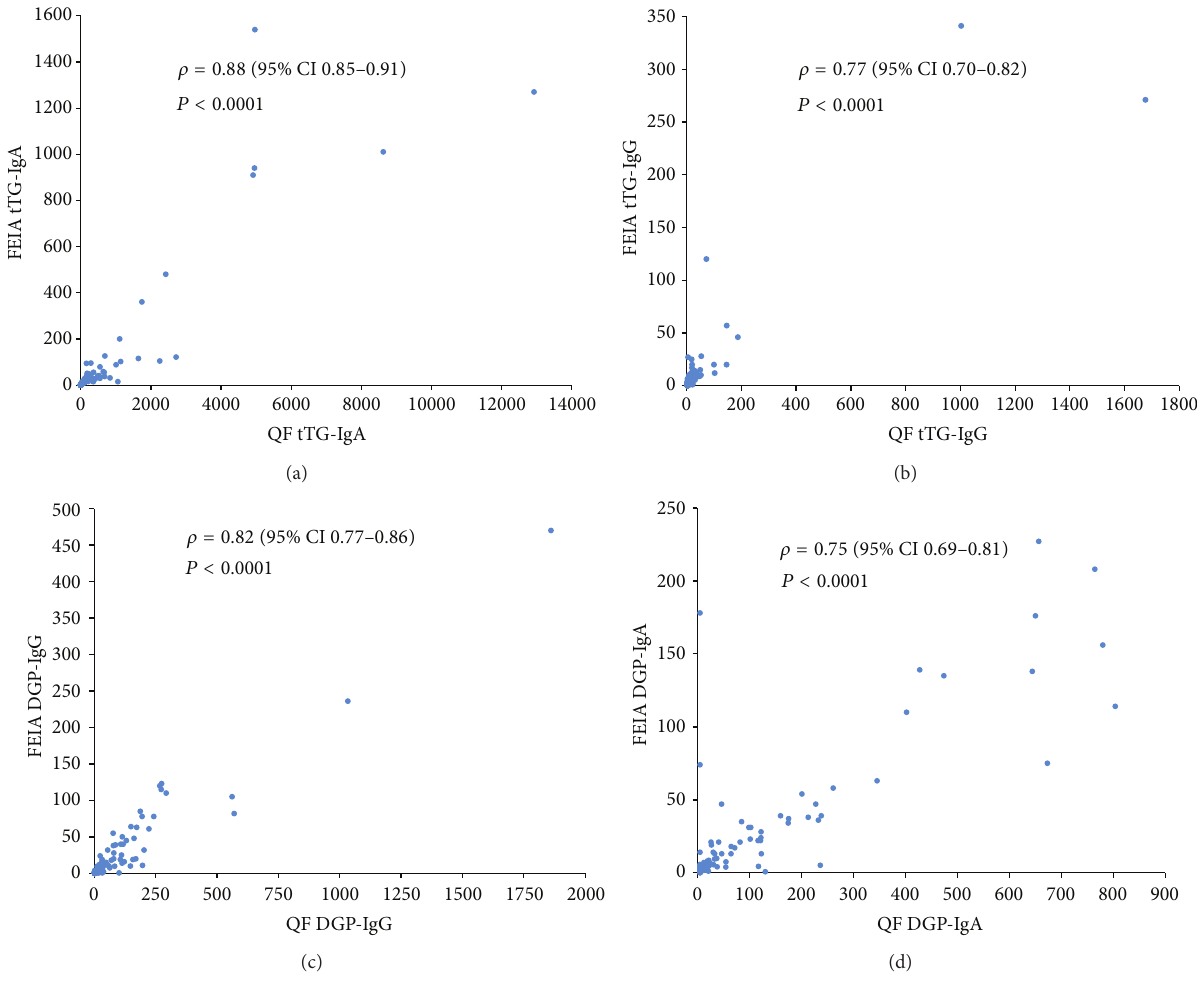
Figure 4: Spearman’s correlation (celiac disease patients and controls, 𝑛 = 212 ) among different assays: (a) tTG-IgA, (b) tTG-IgG, (c) DGP- IgG, and (d) DGP-IgA; QF = QUANTA Flash; FEIA = fluoroenzyme immunoassay.